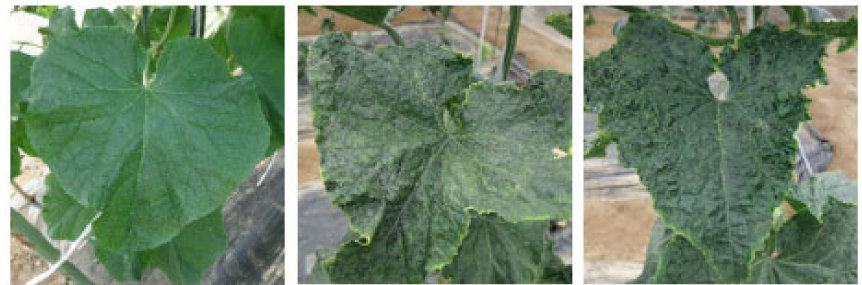
Figure 3. Examples of artificial images generated by LASSR